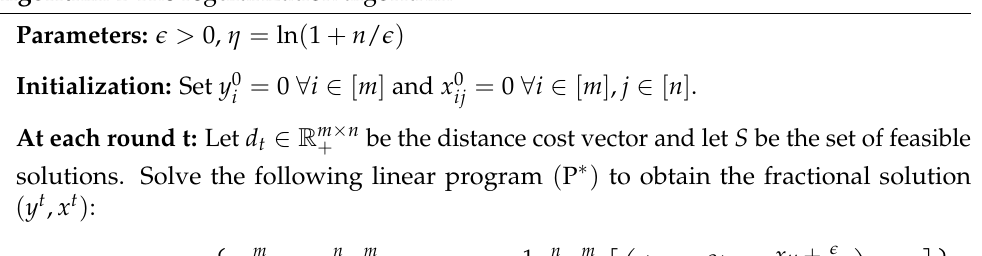
Algorithm 2 (Rounding algorithm) : It rounds the fractional solution Sol ( t ) of Algorithm 1 to an integral solution using competing exponential clocks. Algorithm 1 The regularization algorithm